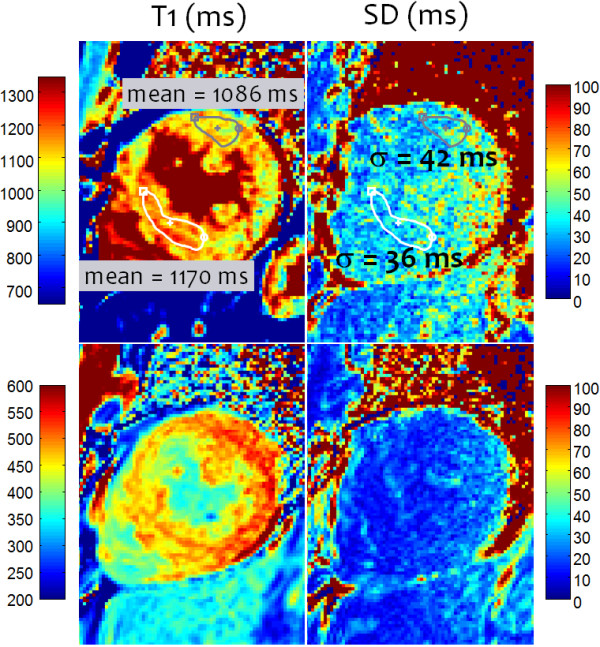
Example T1 and SD maps for subject with HCM acquired pre-contrast (TOP) and post-contrast (BOTTOM). Pre-contrast T1 maps exhibit focal T1 abnormalities in the septal region corresponding to T1 elevation of 84 ms relative to the lateral wall representing an elevation of 2.3 SD on a pixel-wise basis (septal SD = 36 ms).